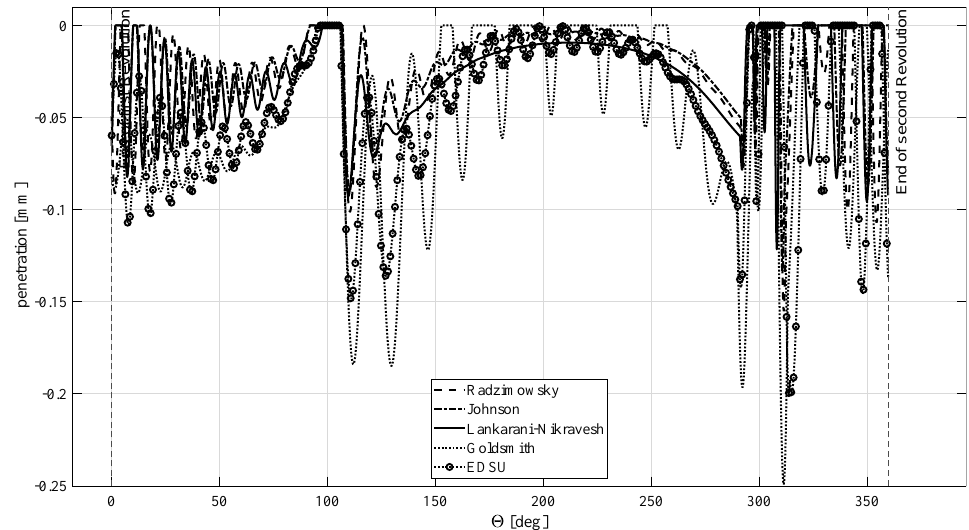
Figure 12. Penetration